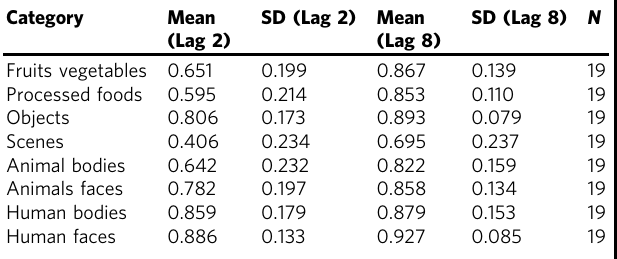
T1. This was true for all layers except for layer 1.